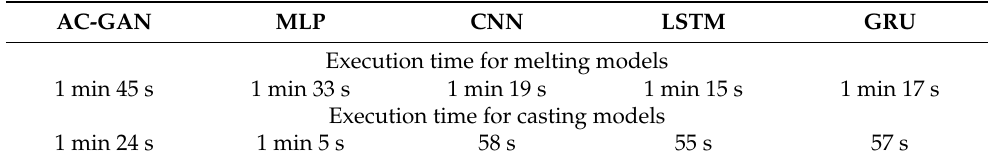
Table 6. Comparison of execution times of models.